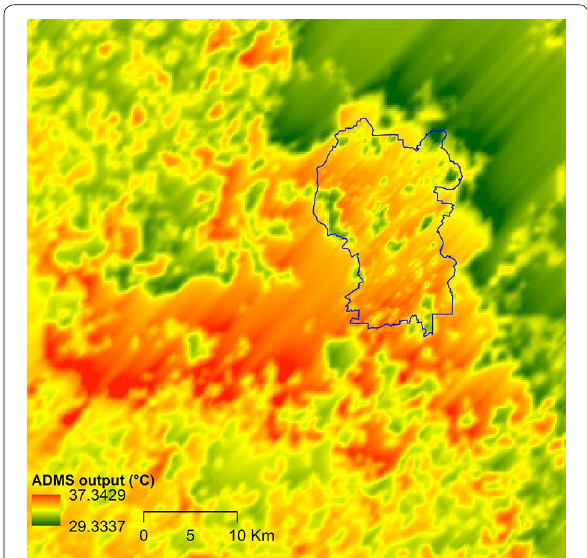
Fig. 6 Temperature distribution over the modelling domain for 18:00, 30 May 2015